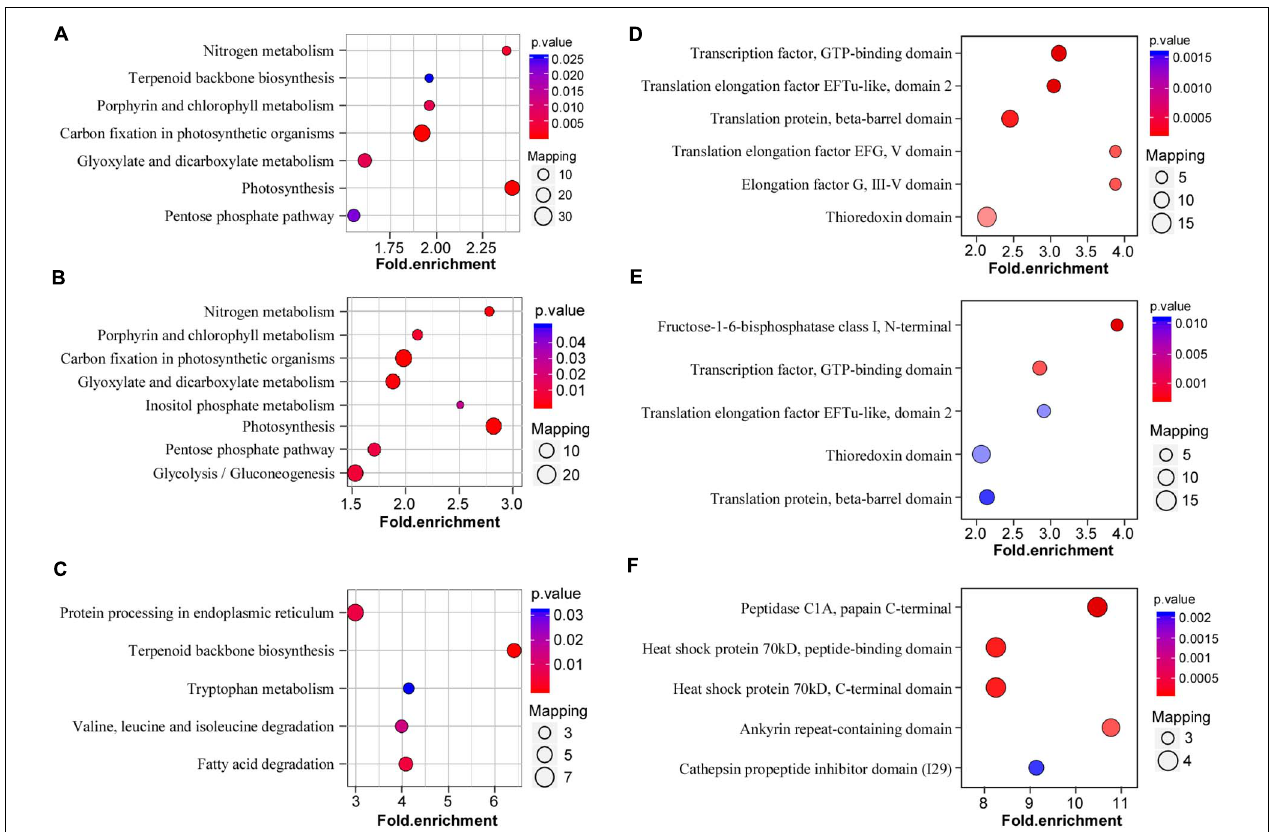
FIGURE 5 | Enrichment analysis and domain enrichment of lysine-acetylated proteins in CWMV-infected N. benthamiana plants. (A) KEGG pathway-based enrichment analysis of proteins in CWMV-infected versus uninfected (CK) plants (–log 10 p > 1.5). (B) KEGG pathway enrichment analysis of upregulated proteins in CWMV-infected versus CK plants (–log 10 p > 1.5). (C) KEGG pathway-based enrichment analysis of downregulated proteins in CWMV-infected versus CK plants (–log 10 p > 1.5). (D) Protein domain enrichment analysis of CWMV-infected versus CK plants. (E) Protein domain enrichment analysis of upregulated proteins in CWMV-infected versus CK plants. (F) Protein domain enrichment analysis of downregulated proteins in CWMV-infected versus CK